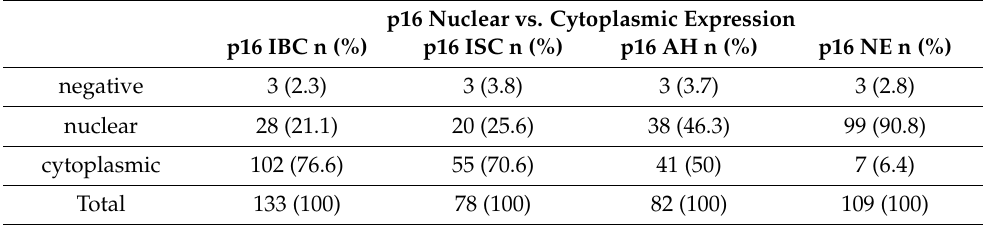
Table 4. Frequency of p16 expression in different subcellular localizations of NIL and IBC epithe- lial cells.